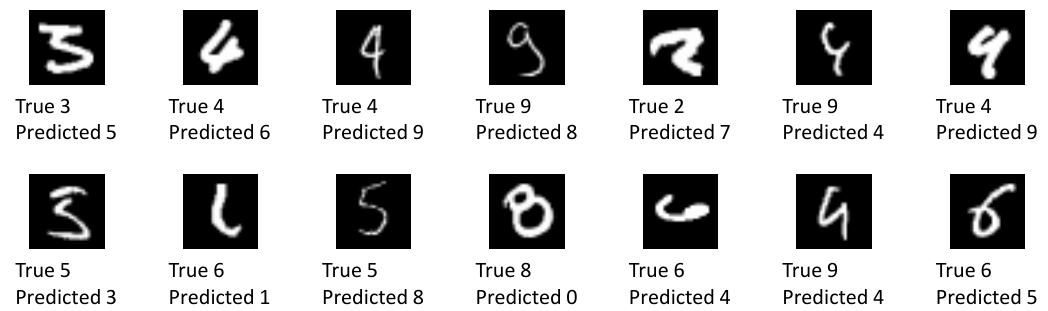
Figure 11. All 14 images where the network was sure within 95% credible intervals about its wrong classification